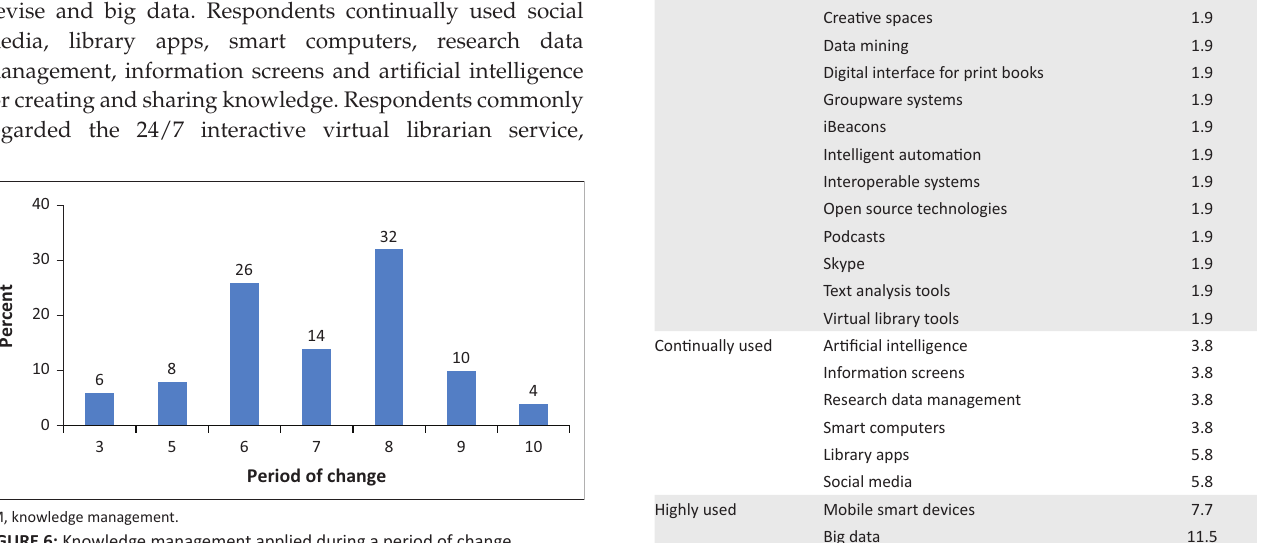
FIGURE 6: Knowledge management applied during a period of change.